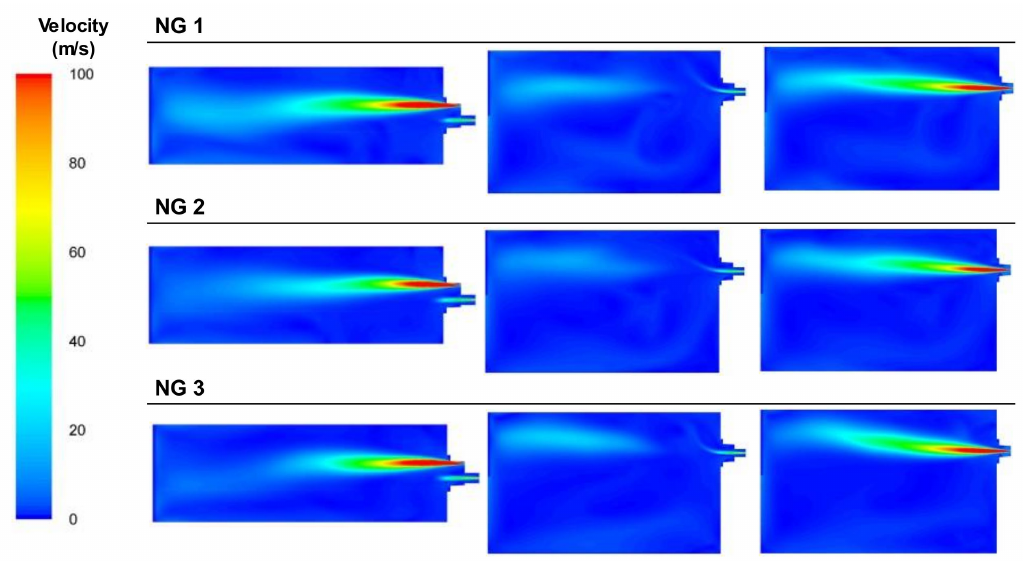
Figure 23. Contour plots of velocities for the NG cases in the XZ1, XY1, and XY2 planes.